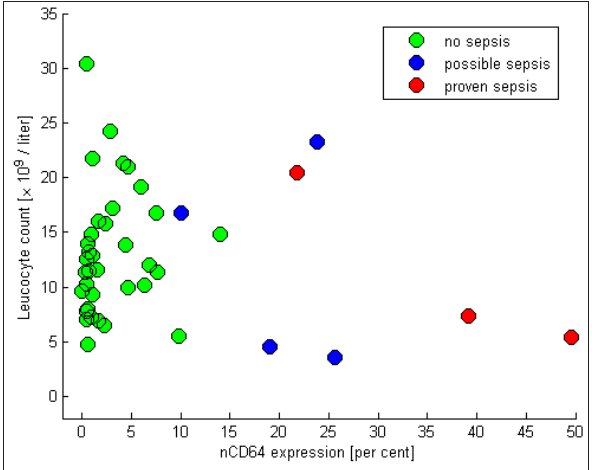
Fig. 5. Comparing markers (leukocyte count and nCD64) and their yields in the diagnosis of LOS. Expression of nCD64 (ver- tical distribution) is clearly better at stratifying patients than leukocyte count (horizontal